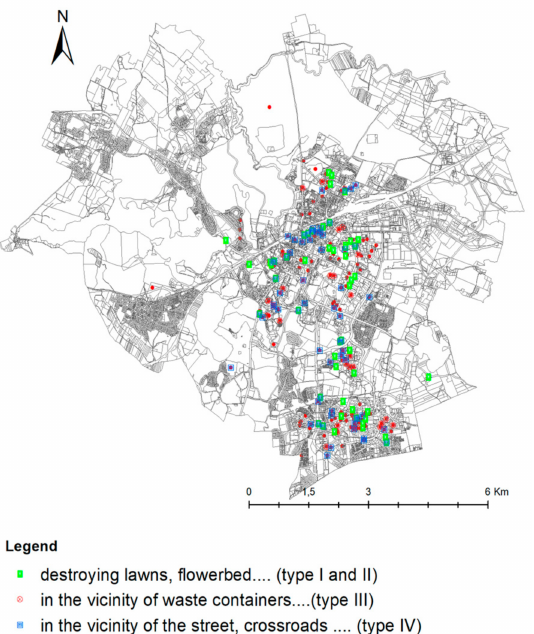
Figure 6. A map presenting the spatial distribution of threats in the city of Olsztyn. Source: own